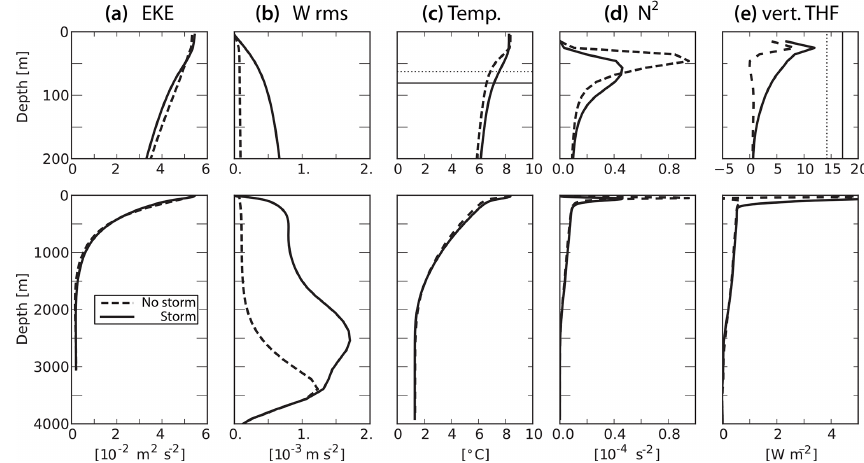
Figure 6. Vertical profile of the 2km experiments with and without storms averaged over a period of 10 years and between L y / 3 and 2 L y / 3 with L y the meridional length of the domain: (a) eddy kinetic energy (m 2 s − 2 ) , (b) rms of the vertical velocity (ms − 1 ) , (c) temperature ( ◦ C), (d) stratification (s − 2 ) and (e) vertical turbulent heat flux (Wm − 2 ) . The eddy kinetic energy is computed from anomalies to the zonal mean. Dashed lines are for the experiment without storms. In (c) the horizontal lines indicate the mean position of the mixed-layer base (computed with a fixed threshold criterion of 0.2 ◦ C relative to the temperature at 10m as in Fig. 2), and in (e) the vertical lines show the average net air–sea heat flux (Wm − 2 )